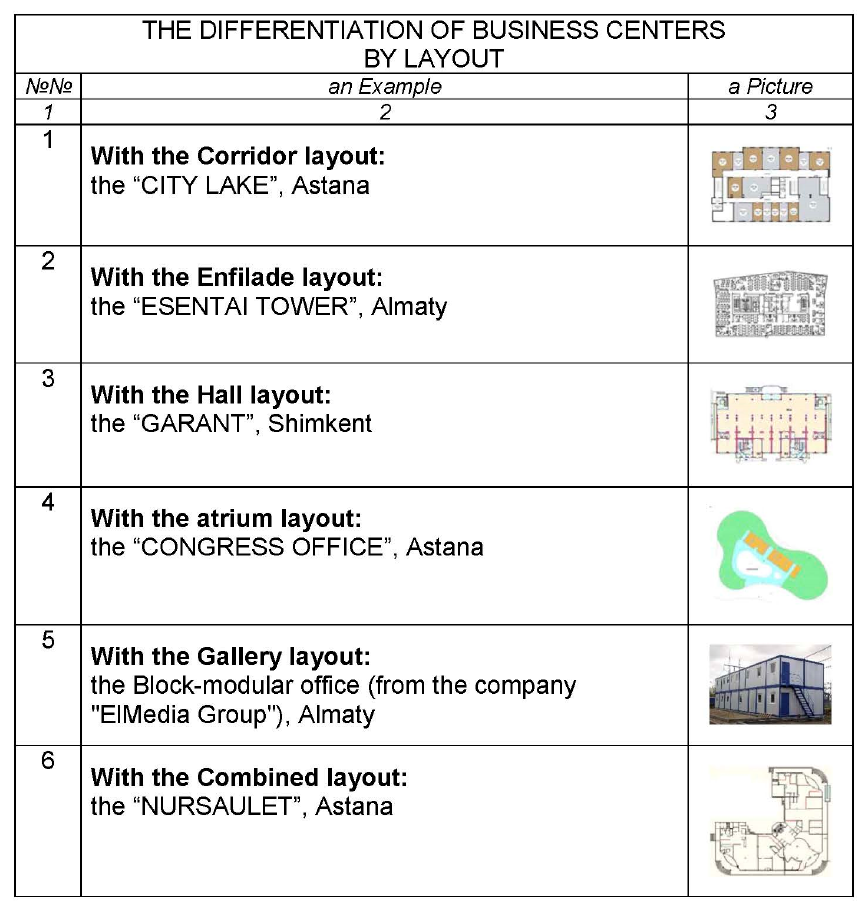
Figure 20. The differentiation of business centers by layout: ( 1 ) the CITY LAKE, Astana [140]; ( 2 ) the ESENTAI TOWER, Almaty [98]; ( 3 ) the GARANT, Shimkent [141]; ( 4 ) the CONGRESS OFFICE, Astana [102]; ( 5 ) the Block-modular office (from the company ElMedia Group), Almaty [142]; and ( 6 ) the NURSAULET, Astana [143].